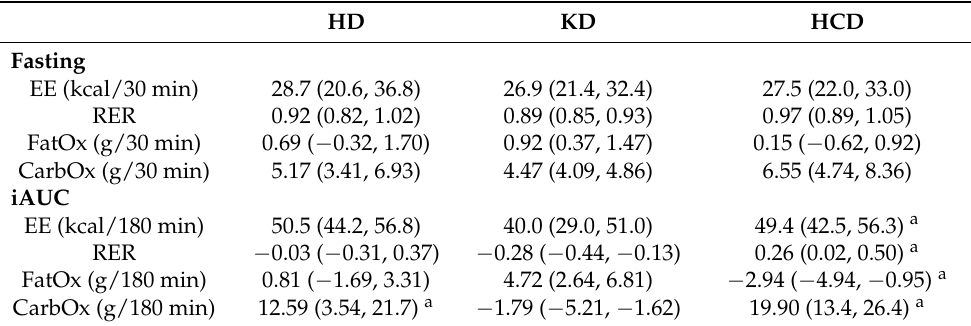
Table 2. Metabolic responses during fasting and for postprandial area under the curve.